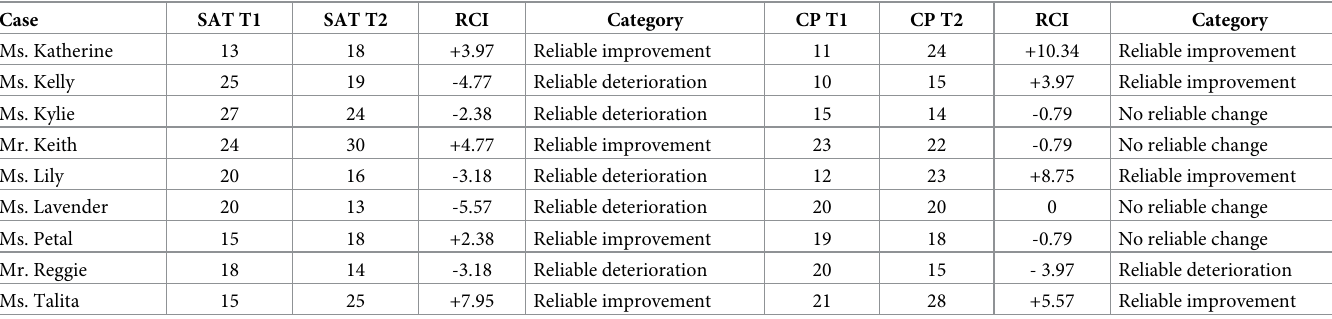
Table 3. RCI’s for Quality of Life Subscale Scores Satisfaction (SAT) and Competence and Productivity (CP) ( N = 9).